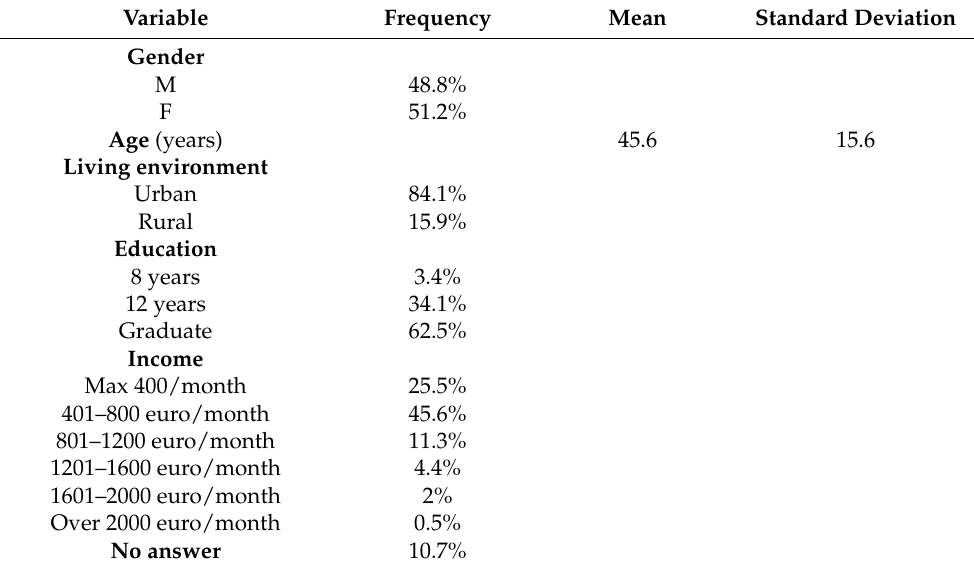
Table 1. Socio-demographic profile of the sample (n =